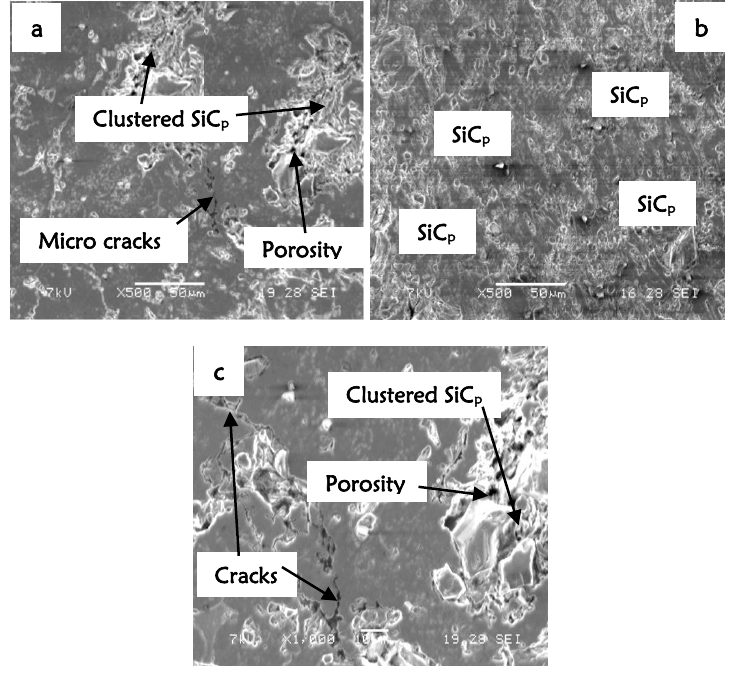
Figure 4: Microstructure of 15 wt% SiCp Al composite processed at (a) 300 rpm (b) 500 rpm and (c) 700 rpm. The formation of composites, porosity, and micro cracks are